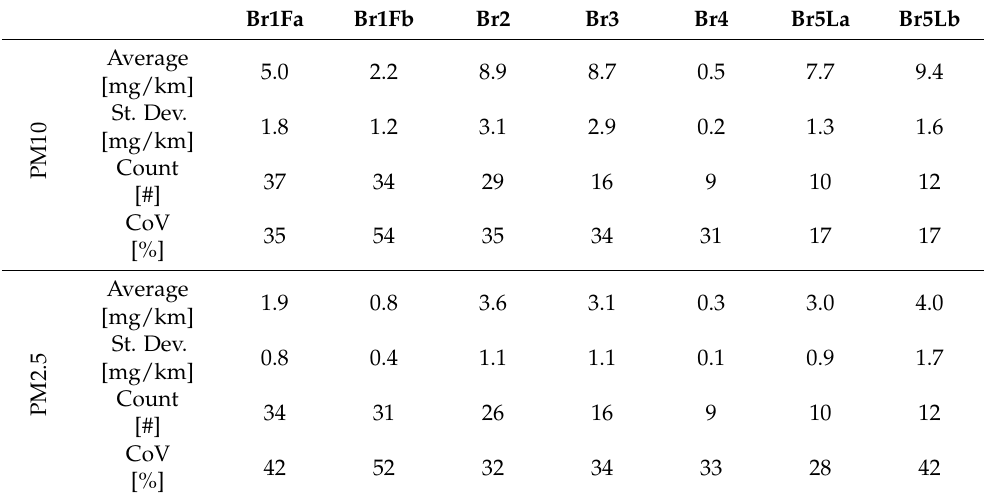
Table 9. PM10 and PM2.5 measurement reproducibility without applying any data filtering (all data considered). The row “count” denotes the number of emission tests used to calculate the CoV.